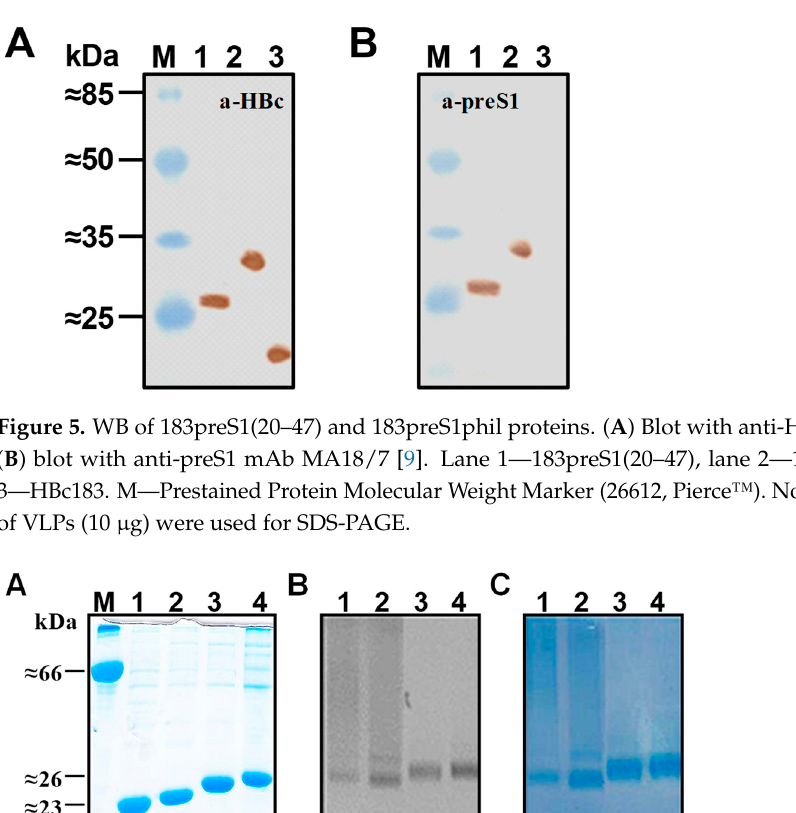
Figure 6. SDS-PAGE and NAGE of HBc-preS1(20–47) VLPs preparations. Loaded proteins: M— BSA, lane 1—163preS1(20–47), lane 2—167preS1(20–47), lane 3—178preS1(20–47), and lane 4— 183preS1(20–47). ( A ) 15% SDS-PAGE, ( B , C ) 1% NAGE in TBE buffer of the same VLP samples: